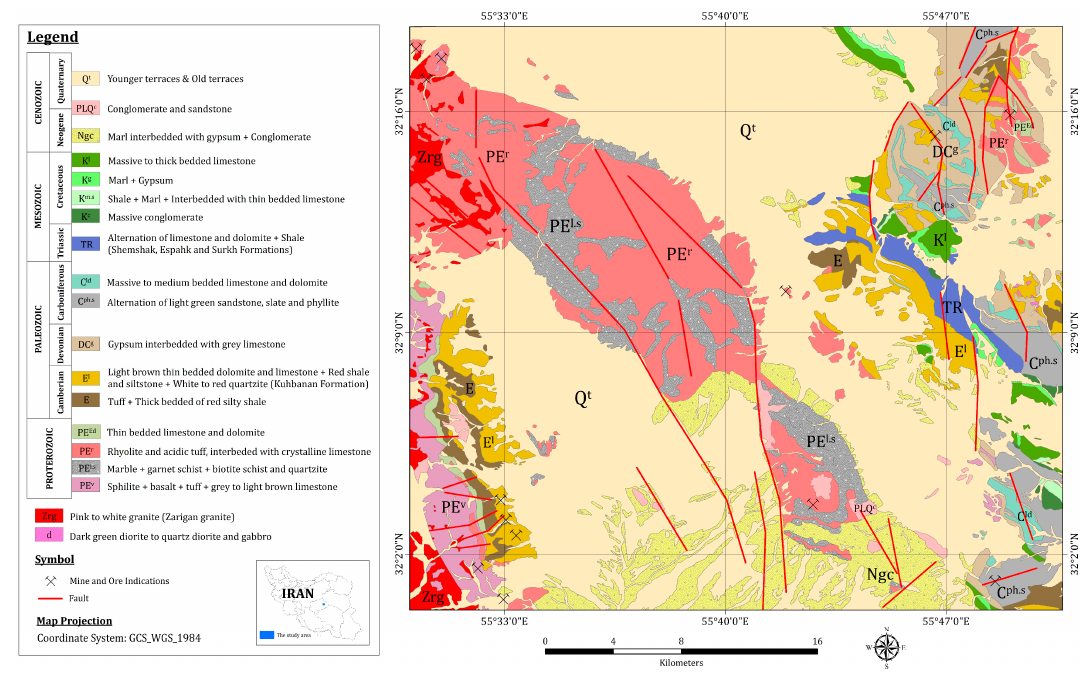
Figure 1. Geology map of the study area (modified from [36]).